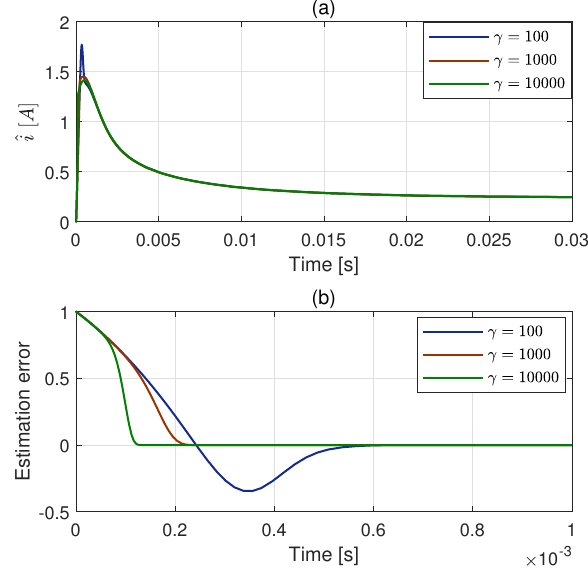
Figure 6. Transient of GPEBO with different γ . ( a ) estimated current ˆ i , ( b ) estimation error.